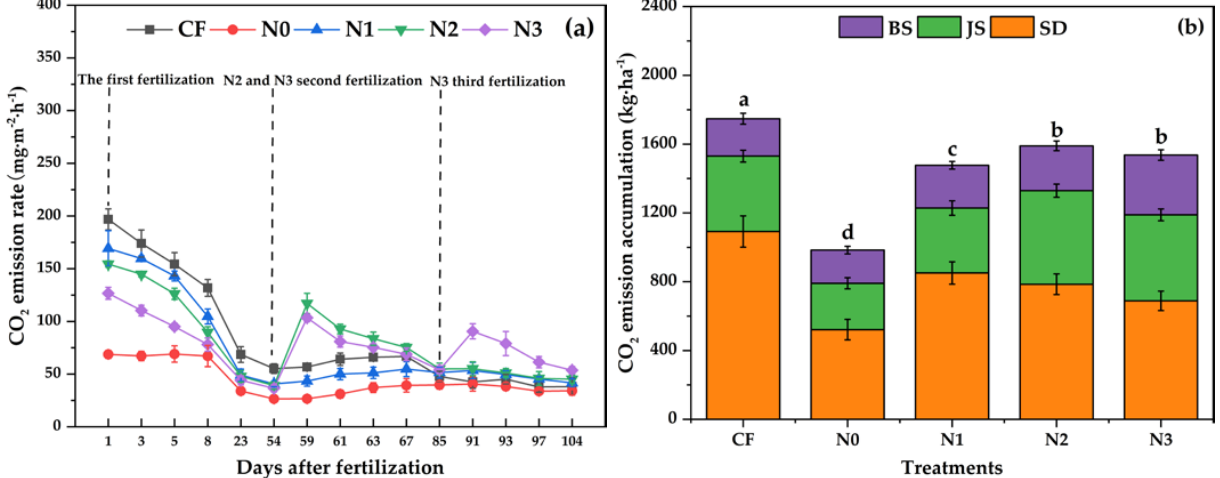
Figure 6. Substitute organic fertilizer for chemical fertilizer and fertilization with stage application method affected ( a ) CO 2 emission rate and ( b ) CO 2 emission accumulation during wheat growth. Note: Different colored columns in ( b ) represent different growth stages; SD, after sowing to jointing before fertilization; JS, after fertilization at jointing to before fertilization at booting; BS, after fertiliza- tion at booting stage. Different lowercase letters indicate significant differences for CO 2 emission accumulation among different treatments throughout the whole growing period (LSD test, p <